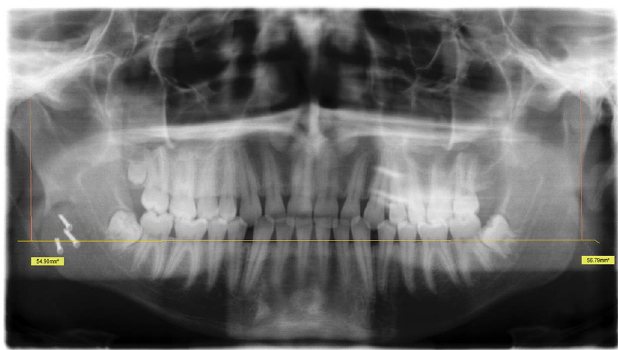
Fig. 3. Orthopantomogramm (P1) 7 years after reconstruction of the right ascending jaw and condyle with a costochondral rib graft with a comparative digital measurement of the